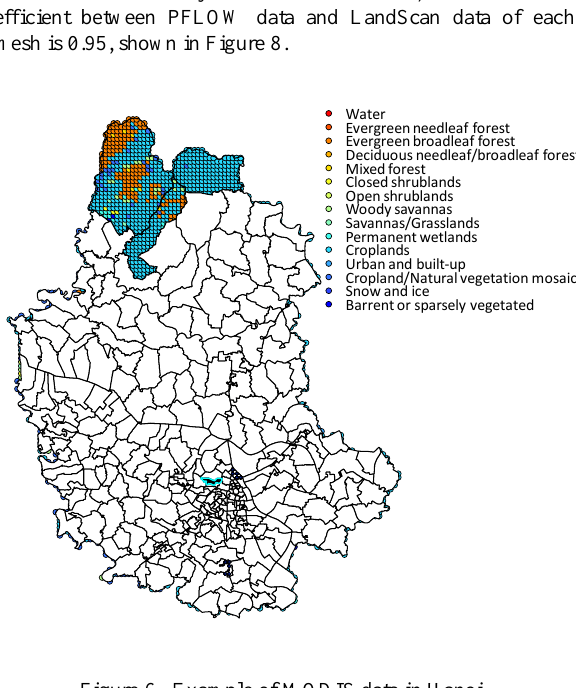
Figure 6. Example of MODIS data in Hanoi.